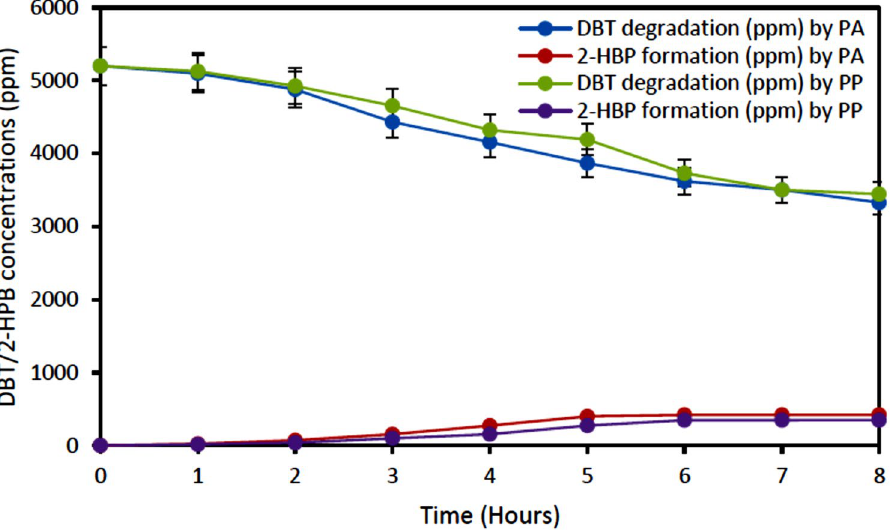
Figure 10. Biodesulfurization of diesel sample before HDS (5200 ppm). Experimental condition: Cell concentration 1.2 g DCW/L, Time 8 h, Temperatures 30 °C and 37 °C for resting cells of Pseudomonas aeruginosa and Pseudomonas putida , respectively, Shaking speed 130